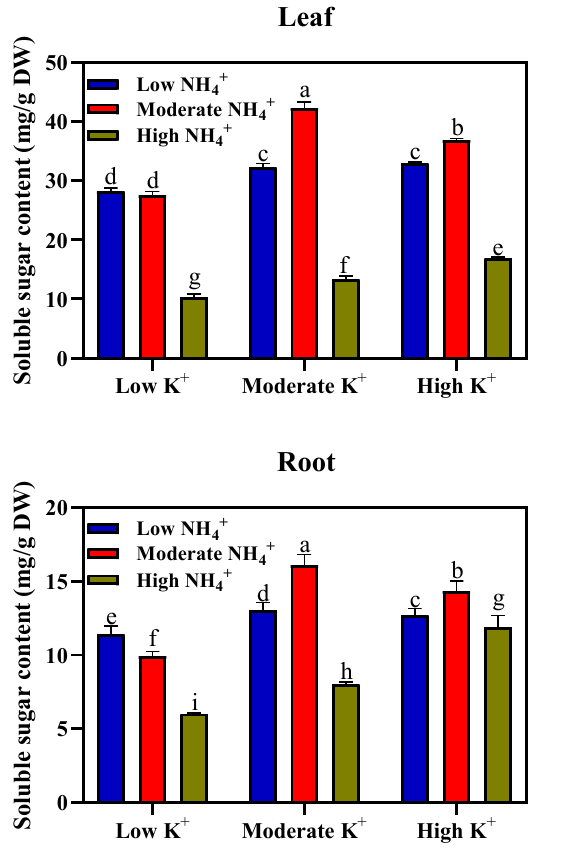
Figure 1. Soluble sugar concentration in leaves, stems, and roots (mg/g DW) of tobacco seedlings under different NH 4+ and K + levels. Different letters indicate significant differences between means ± SD at the p < 0.05 level ( n = 9).